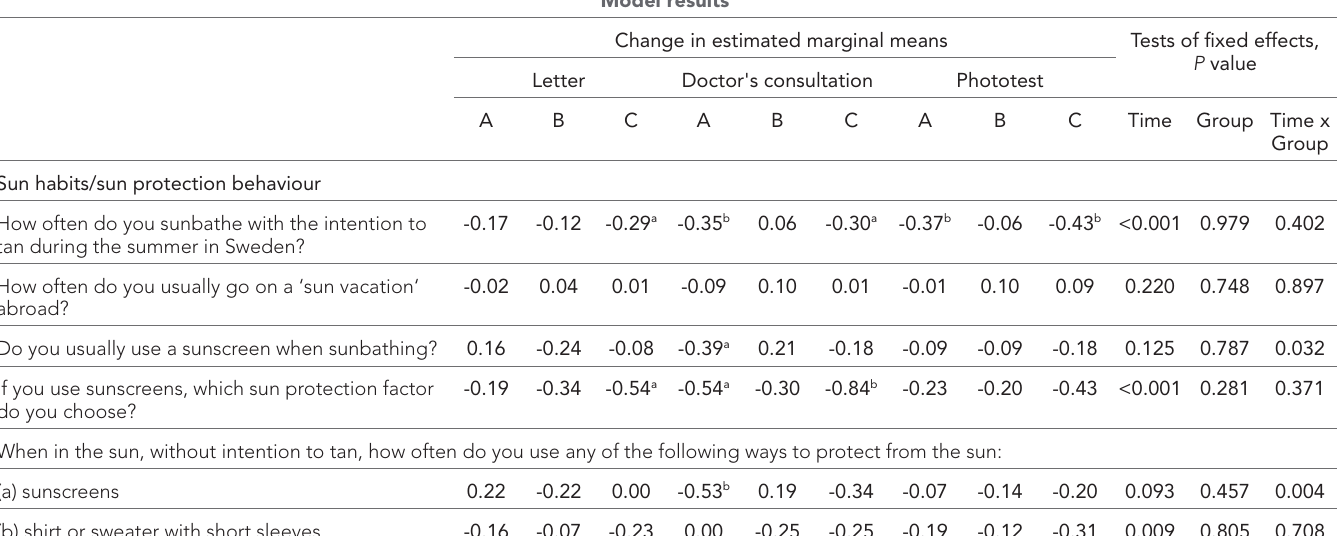
Table 2 Mean changes of score between the three follow-up occasions (baseline, 3 years, and 10 years), regarding sun habits and